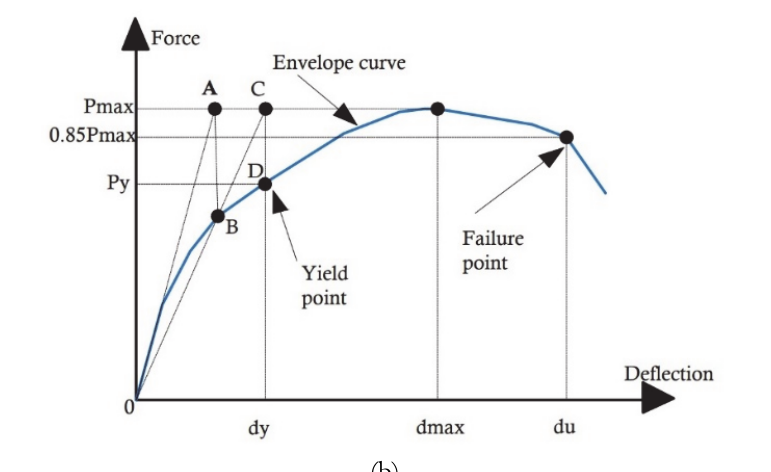
(b) Figure 3: Yield point from envelope curves (a) and (b).